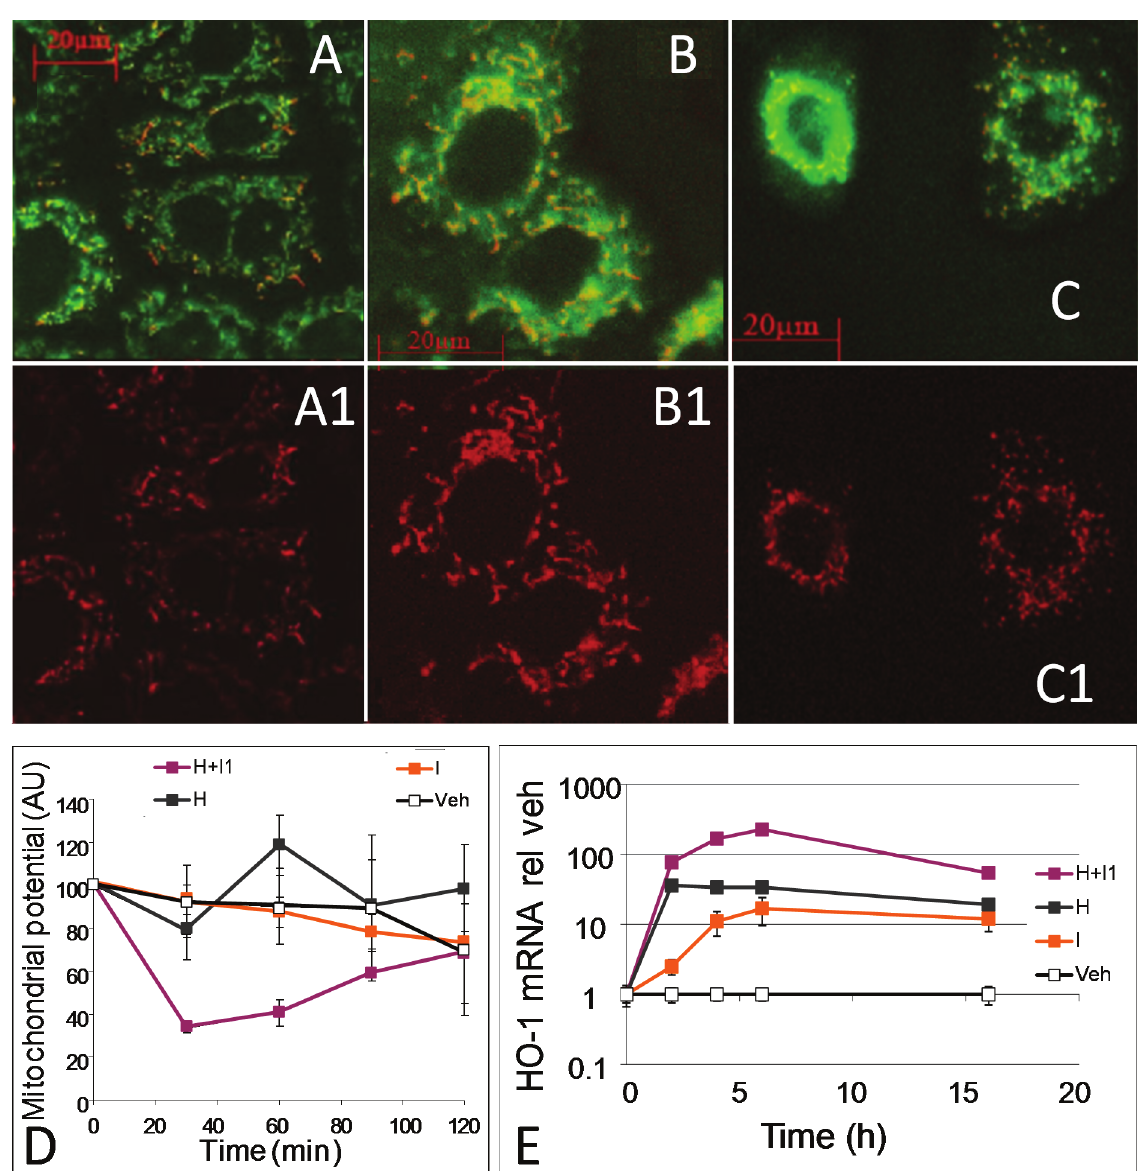
Figure 3. Effect of hemin and zinc protoprophyrin IX on mitochondrial function and morphology in hepatocytes. Liver cells (BRL3A) were incubated with JC-1 for 30 min, thereafter vehicle (DMSO, A ) or hemin (20 μM); ( B , C )) was added. Zinc protoporphyrin (ZnIXPP), a competitive inhibitor of HO (0.2 μM); was added 10 min before ( C ). Cells were analyzed after 2 h. A1 , B1 and C1 show energized mitochondria (fluorescence at 590 nm). Competitive inhibition of HO by ZnIXPP resulted in delayed fragmentation of mitochondria ( C1 ); ( D ) Effect of hemin (H, grey line), HO-inhibitor ZnIXPP (I, orange line), and hemin plus inhibitor (H+I1, violet line) in the concentrations indicated above on quantification of mitochondrial potential (intensity of background normalized JC-1 fluorescence (emission at 590 nm) was used as a parameter for mitochondrial potential); ( E ) Effect of hemin (H, grey line), HO-inhibitor ZnIXPP (I, orange line), and hemin plus inhibitor (H+I, violet line) in the concentrations indicated above on HO-1 mRNA expression in BRL3A cells determined by qPCR. Data are given as means (±SD) obtained from one representative experiment using n = 4